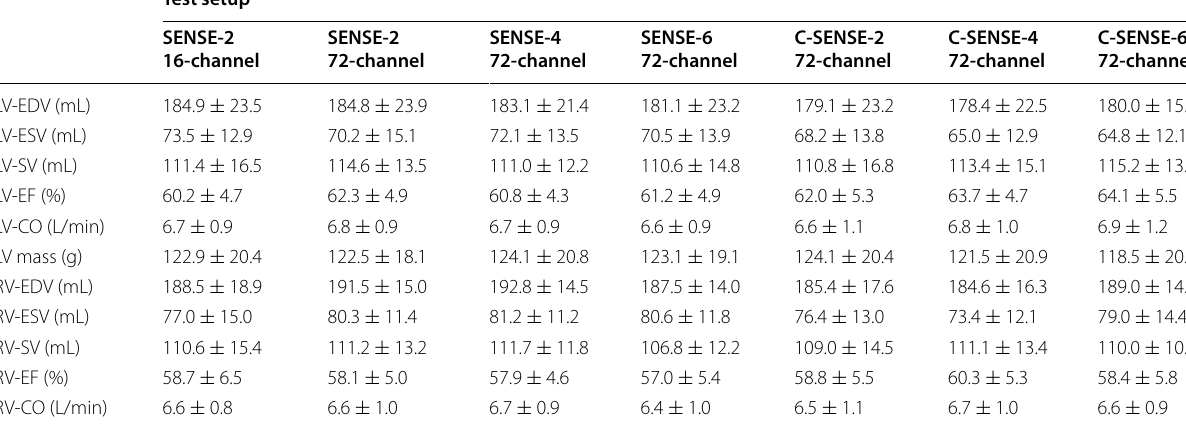
Data are presented as the mean standard deviation. CO Cardiac output, C-SENSE Compressed sensitivity encoding, EDV End-diastolic volume, EF Ejection fraction, ± ESV End-systolic volume, LV Left ventricle, RV Right ventricle, SENSE Sensitivity encoding, SV Stroke